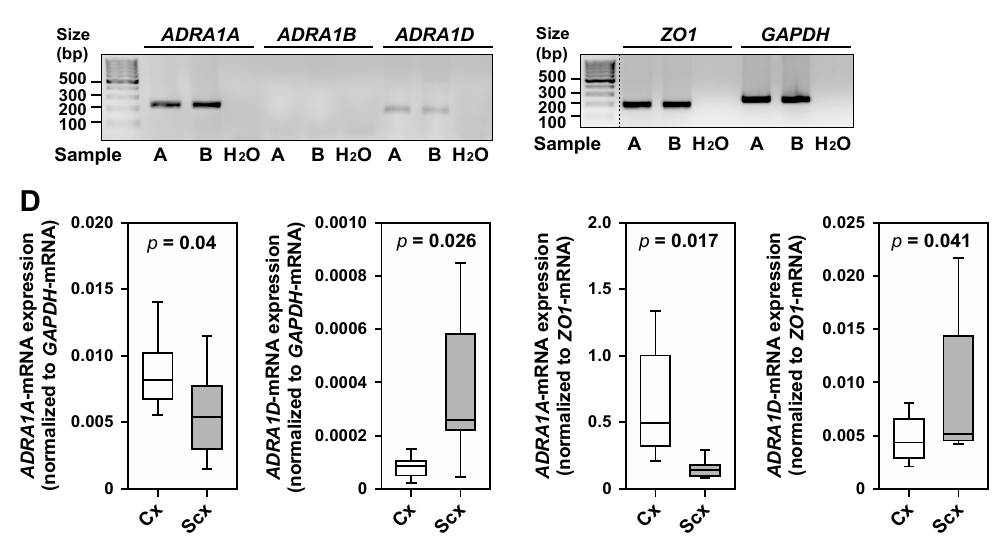
Figure 5. Expression of α 1-adrenergic receptors in cortical and subcortical brain arterioles. ( A ) Western blot analysis was performed for cortical and subcortical brain arterioles from 14 sheep, as described in the methods section. α 1-adrenergic receptors ( α 1-AR) are detectable in cortex (Cx) and subcortex (Scx). 1–4, samples from different sheep; AU, arbitrary units; Ref., reference sample; ( B ) Quantification of receptor expression after normalization of band intensities to the housekeeping protein β -actin shows no differences of expression levels in cortex and subcortex, respectively; ( C ) Quantitative PCR-analysis was done using cDNA reverse transcribed from total RNA of 7 sheep. PCR-products of correct size were consistently detected for housekeeping genes GAPDH and ZO-1 , and for the α 1-adrenergic receptors A ( ADRA1A ) and D ( ADRA1D ), but not for the B-subtype receptor ( ADRA1B ). A, B, depict examples from two individual sheep; H 2 O, no cDNA control; ( D ) Quantitation of receptor mRNA-expression in relation to the GAPDH mRNA and the ZO-1 mRNA , respectively, by the ΔΔ C t -method. As some data sets were not normally distributed all quantitations are presented as box plots, where boxes represent 25th and 75th percentiles, respectively. Medians are indicated by horizontal lines. Whiskers indicate 10th and 90th percentiles, respectively. p -values indicating significant differences are given in the panels.